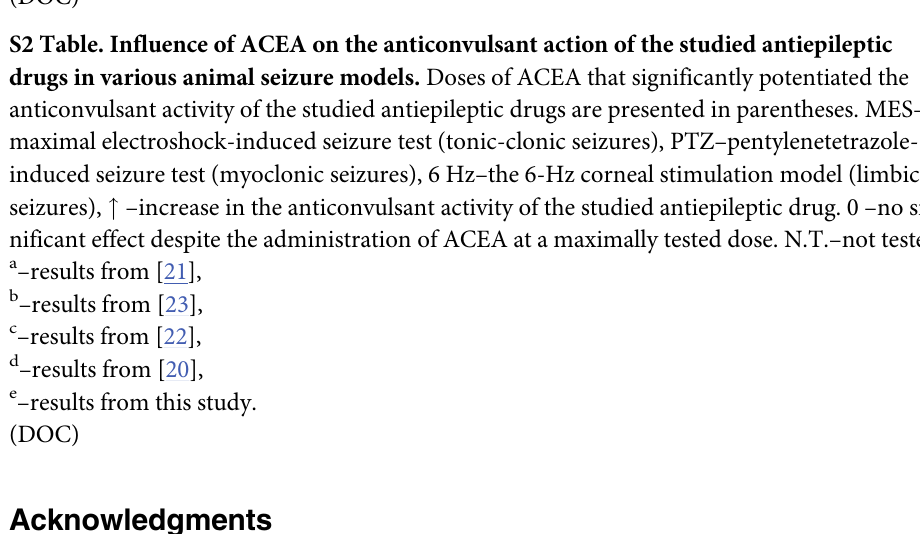
S1 Table. Anticonvulsant activity of clobazam (CLB), lacosamide (LCM), levetiracetam (LEV), phenobarbital (PB), tiagabine (TGB), valproate (VPA) alone and in combination with PMSF and ACEA in the 6-Hz corneal stimulation model. First column represents